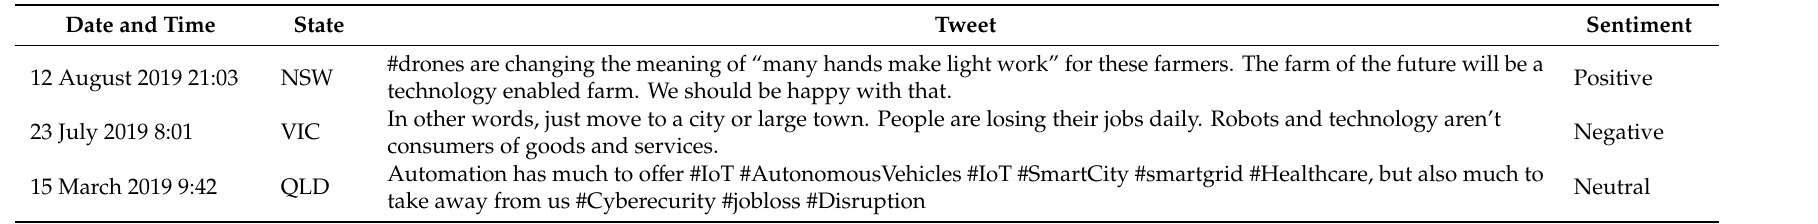
Table 2. Example tweets for three sentiment categories.